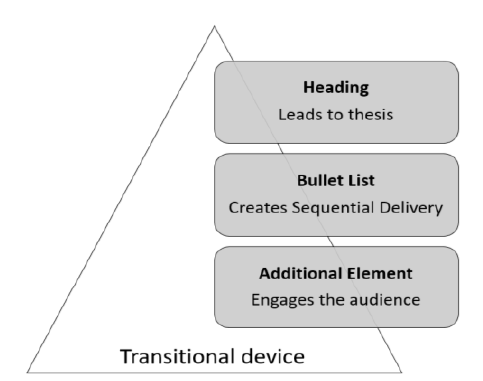
Figure 1. Strategy Model Employed by the Students in Multimedia-Based